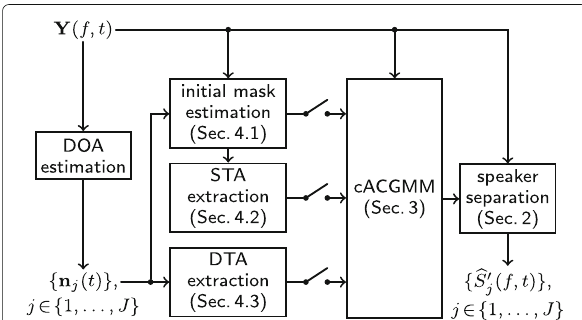
Fig. 2 DOA-GSS block diagram. We consider three different ways to make use of DOA knowledge: a DOA-based initialization of the cACGMM parameter estimation (see Section 4.1), extracting time annotations from the initial masks (Section 4.2), or using one mixture component for each discrete DOA (Section 4.3). These can be used independently or